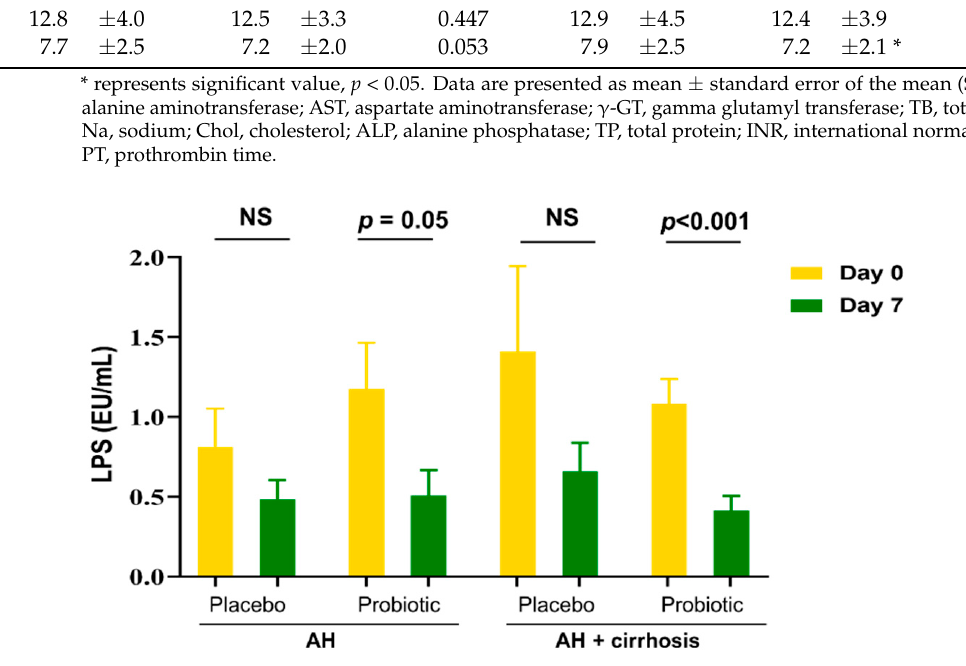
Figure 2. LPS level measurement in placebo and probiotics groups at day 0 and at day 7. LPS level in all patients (Lt) and cirrhosis and non-cirrhosis patients (Rt). Data are presented as mean ± standard error of the mean (SEM). p < 0.05 was considered significant. NS, non-significant; LPS, lipopol- ysaccharide . Table 2. Patients’ clinical characteristics and changes in liver function tests.